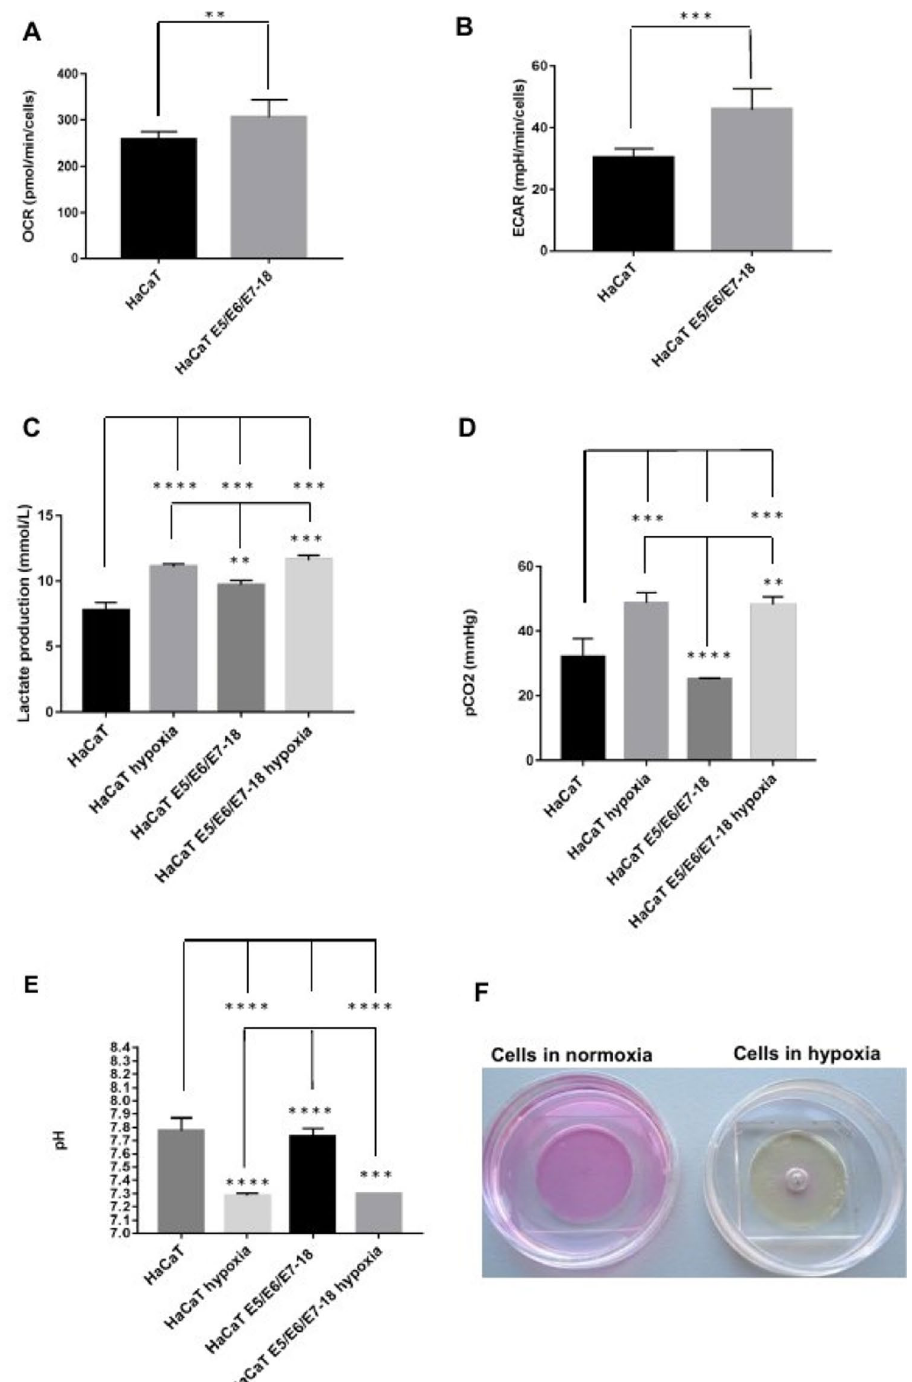
Figure 2. Measurement of metabolic parameters in HaCaT parental and HaCaT E5/E6/E7-18 cell lines. ( A ) Oxygen Consumption Rate (OCR) ( B ) Extracellular Acidification Rate (ECAR) ( C ) Lactate production levels measured in HaCaT parental and HaCaT E5/E6/E7–18 cells in normoxia and hypoxia conditions. ( D ) CO 2 levels measured in HaCaT parental and HaCaT E5/E6/E7-18 cells in normoxia and hypoxia conditions. ( E ) pH measurements in HaCaT parental and HaCaT E5/E6/E7–18 cells in normoxia and hypoxia. ( F ) Changes in phenol red culture medium can be seen after coverslip treatment. (*) P < 0.05, (**) P < 0.01, (***) P <